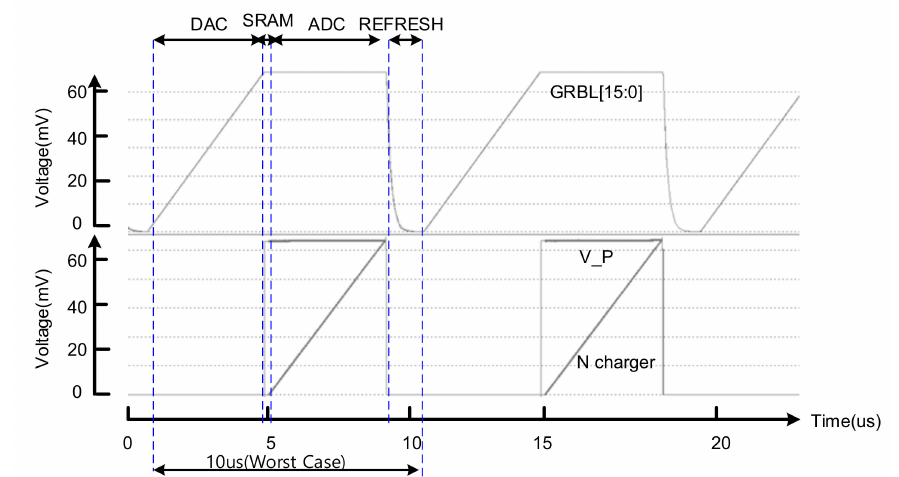
Figure 17. The simulation results of the analog processor-in-memory core.